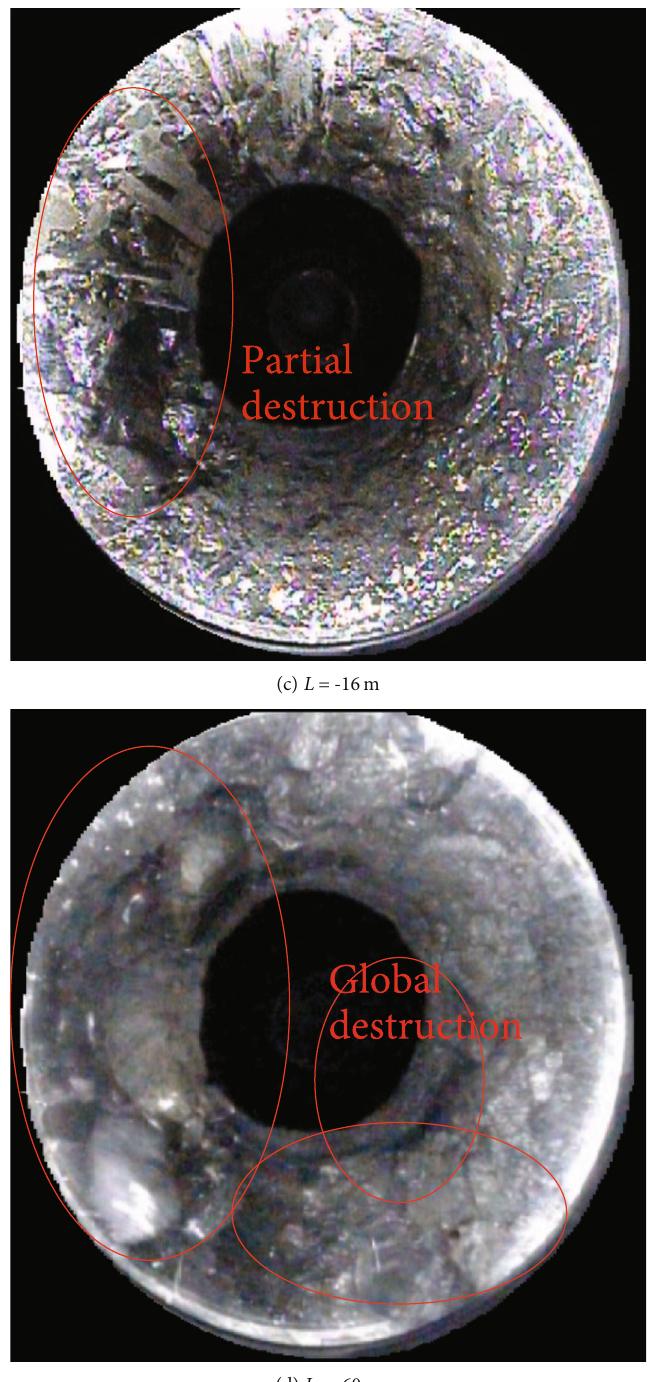
Figure 7: Image of the damage and deformation at a vertical depth of 10-11m ( “ L ” is the distance from the face end to the measuring